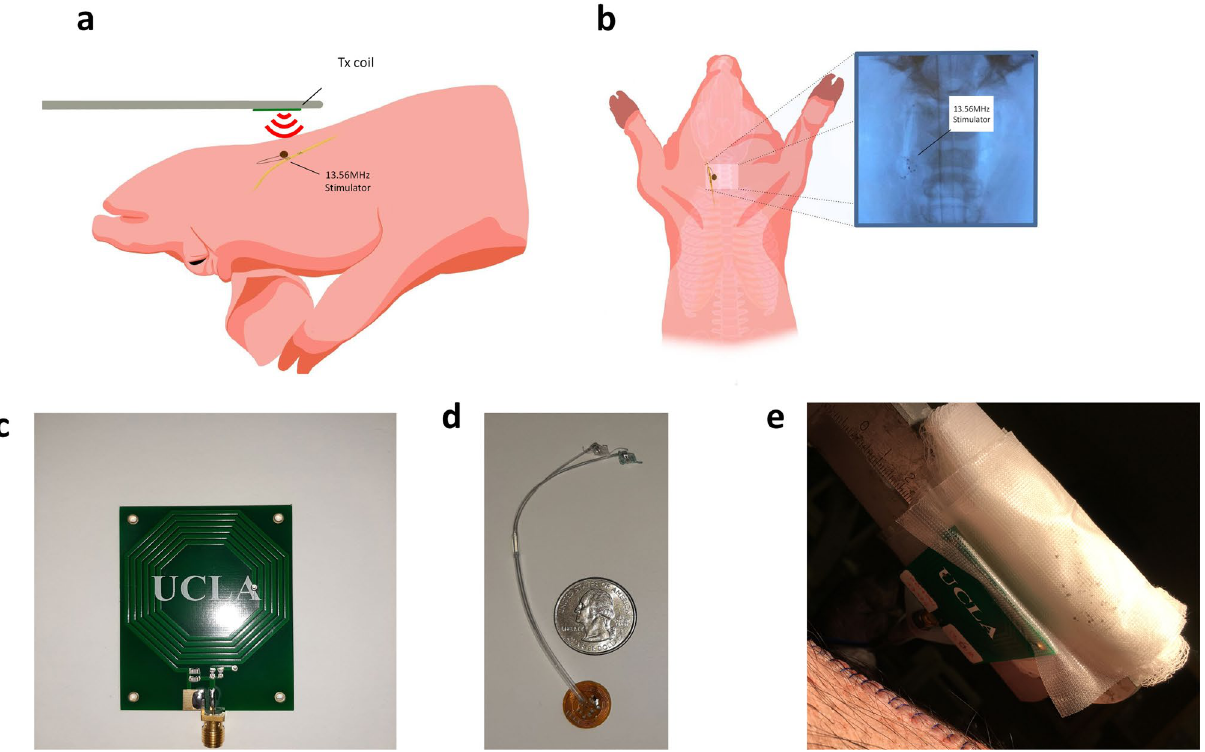
Figure 1. Conceptual representation of the VNS system and photos of the designed stimulator. ( a ) Conceptual illustration of wirelessly powered VNS setup. ( b ) X-ray image of the device after implantation. ( c ) 45 mm diameter Tx coil used for transmitting power and data. ( d ) Picture of stimulator compared to US quarter. ( e ) Picture of the pig after suturing the incision with the flexible stimulator inside the